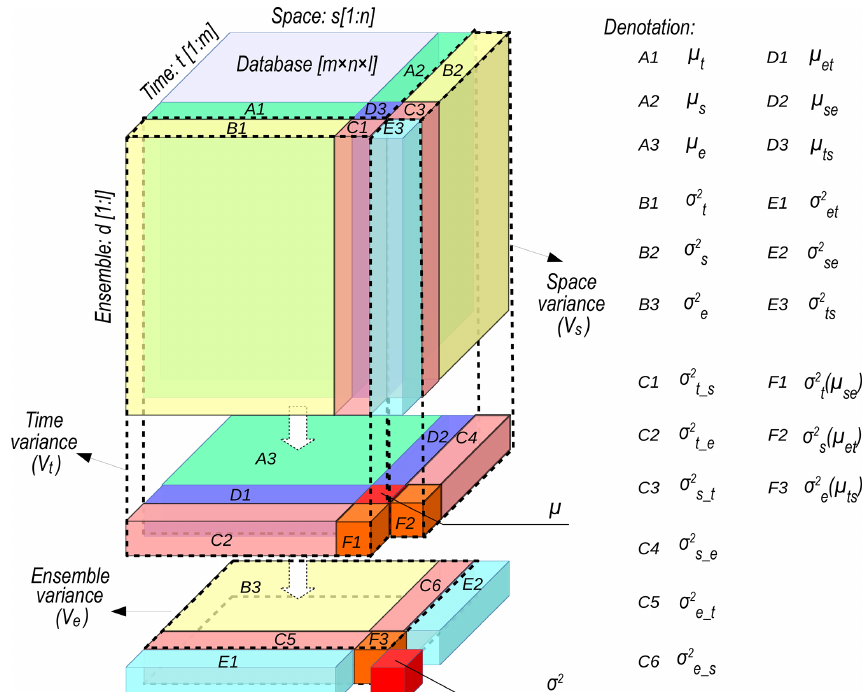
Figure 2. Partitioning the temporal–spatial-ensemble variance. The original database is re-organized into three dimensions: time, space and ensemble. Zones with different colours represent different processes based on the original database through different dimensions. The labels of the zones are listed on the right; detailed definitions can be found in Appendix A. The grand variance is σ 2 and the grand mean is µ . The subscripts t, s, and e indicate dimensions of time, space and ensemble, respectively. In Zone A, µ x shows the mean values across the x dimension ( x = t, s or e); in Zone B, σ 2 x indicates the variation across the x dimension; in Zone C, σ 2 x _ y indicates the variation across the x dimension of µ y ( y = t, s or e); in Zone D, µ xy indicates the means across the x and y dimensions; in Zone E, σ 2 xy indicates the variation across the x and y dimensions; in Zone F, σ 2 x (µ yz ) indicates the variation across the x dimension of the means across the y and z dimensions ( z = t, s or e).